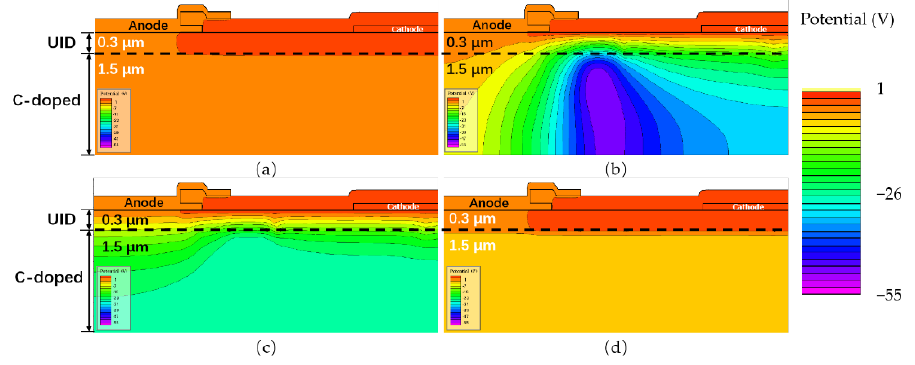
Figure 7. The potential distribution at different timings. ( a ) t 0 : the initial state without electrical stress; ( b ) t 1 : 1 s after the electrical stress; ( c ) t 2 : 20 s after the electrical stress; and ( d ) t 3 : 10,000 s after the electrical stress.